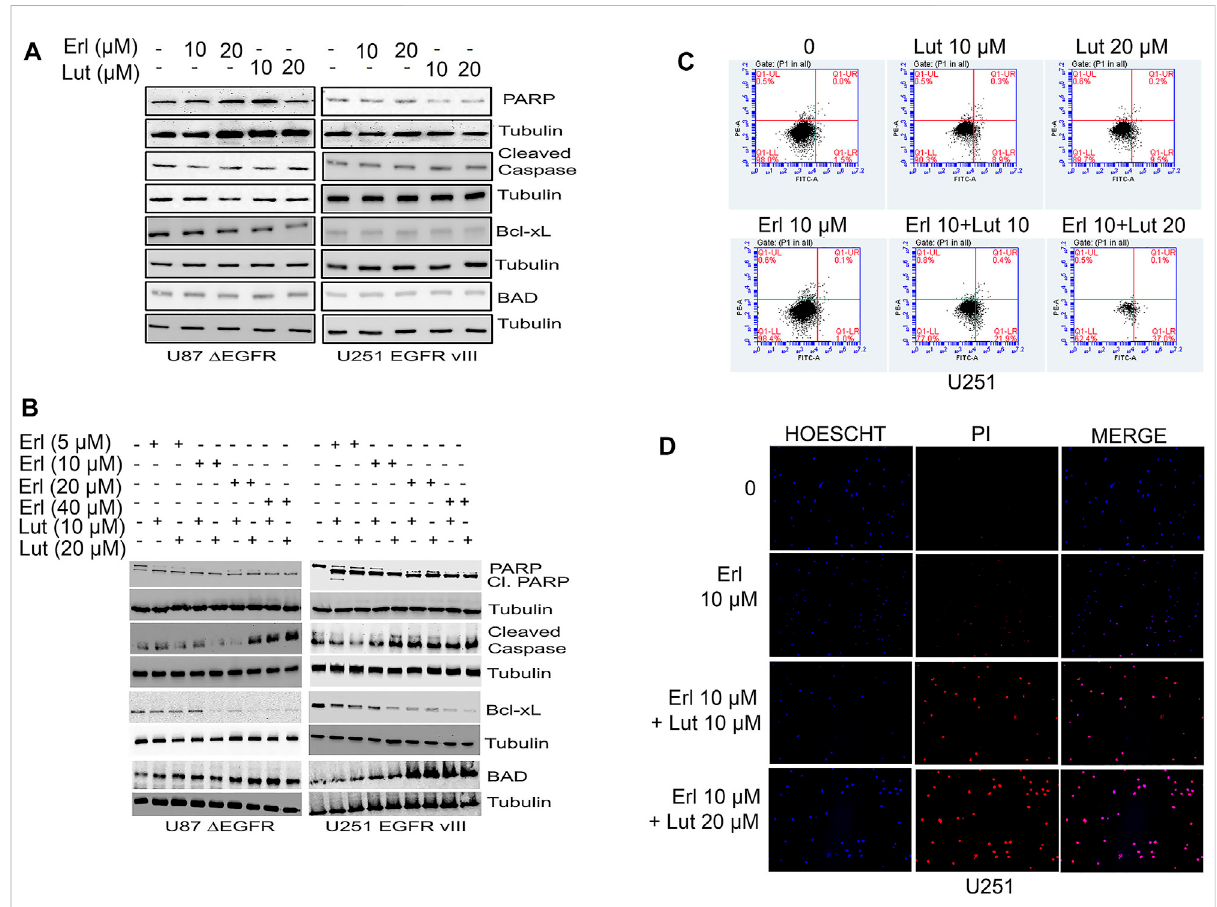
FIGURE 5 Effects of erlotinib and luteolin on apoptotic signaling proteins. (A) Effects of erlotinib and luteolin alone on key apoptotic signaling proteins such as PARP, Bcl-xL, and BAD on U87 Δ EGFR and U251 EGFR vIII. (B) Effects of combined treatment with erlotinib and luteolin on induction of key apoptotic signaling proteins such as PARP, Bcl-xL, and BAD on glioblastoma cells overexpressing the EGFR VIII (U87 Δ EGFR and U251 EGFR vIII). (C) Effects oferlotinib and luteolinon cellular apoptosis asmeasuredbyAnnexin V andPI stain.The combined treatment with erlotinib andluteolin induced signi fi cant ( p < 0.05) early apoptotic events. (D) Effects of erlotinib and luteolin on cellular staining with both PI and HOESCHT 33342. The combined effects of erlotinib and luteolin compromised the cells as evident by an increased PI